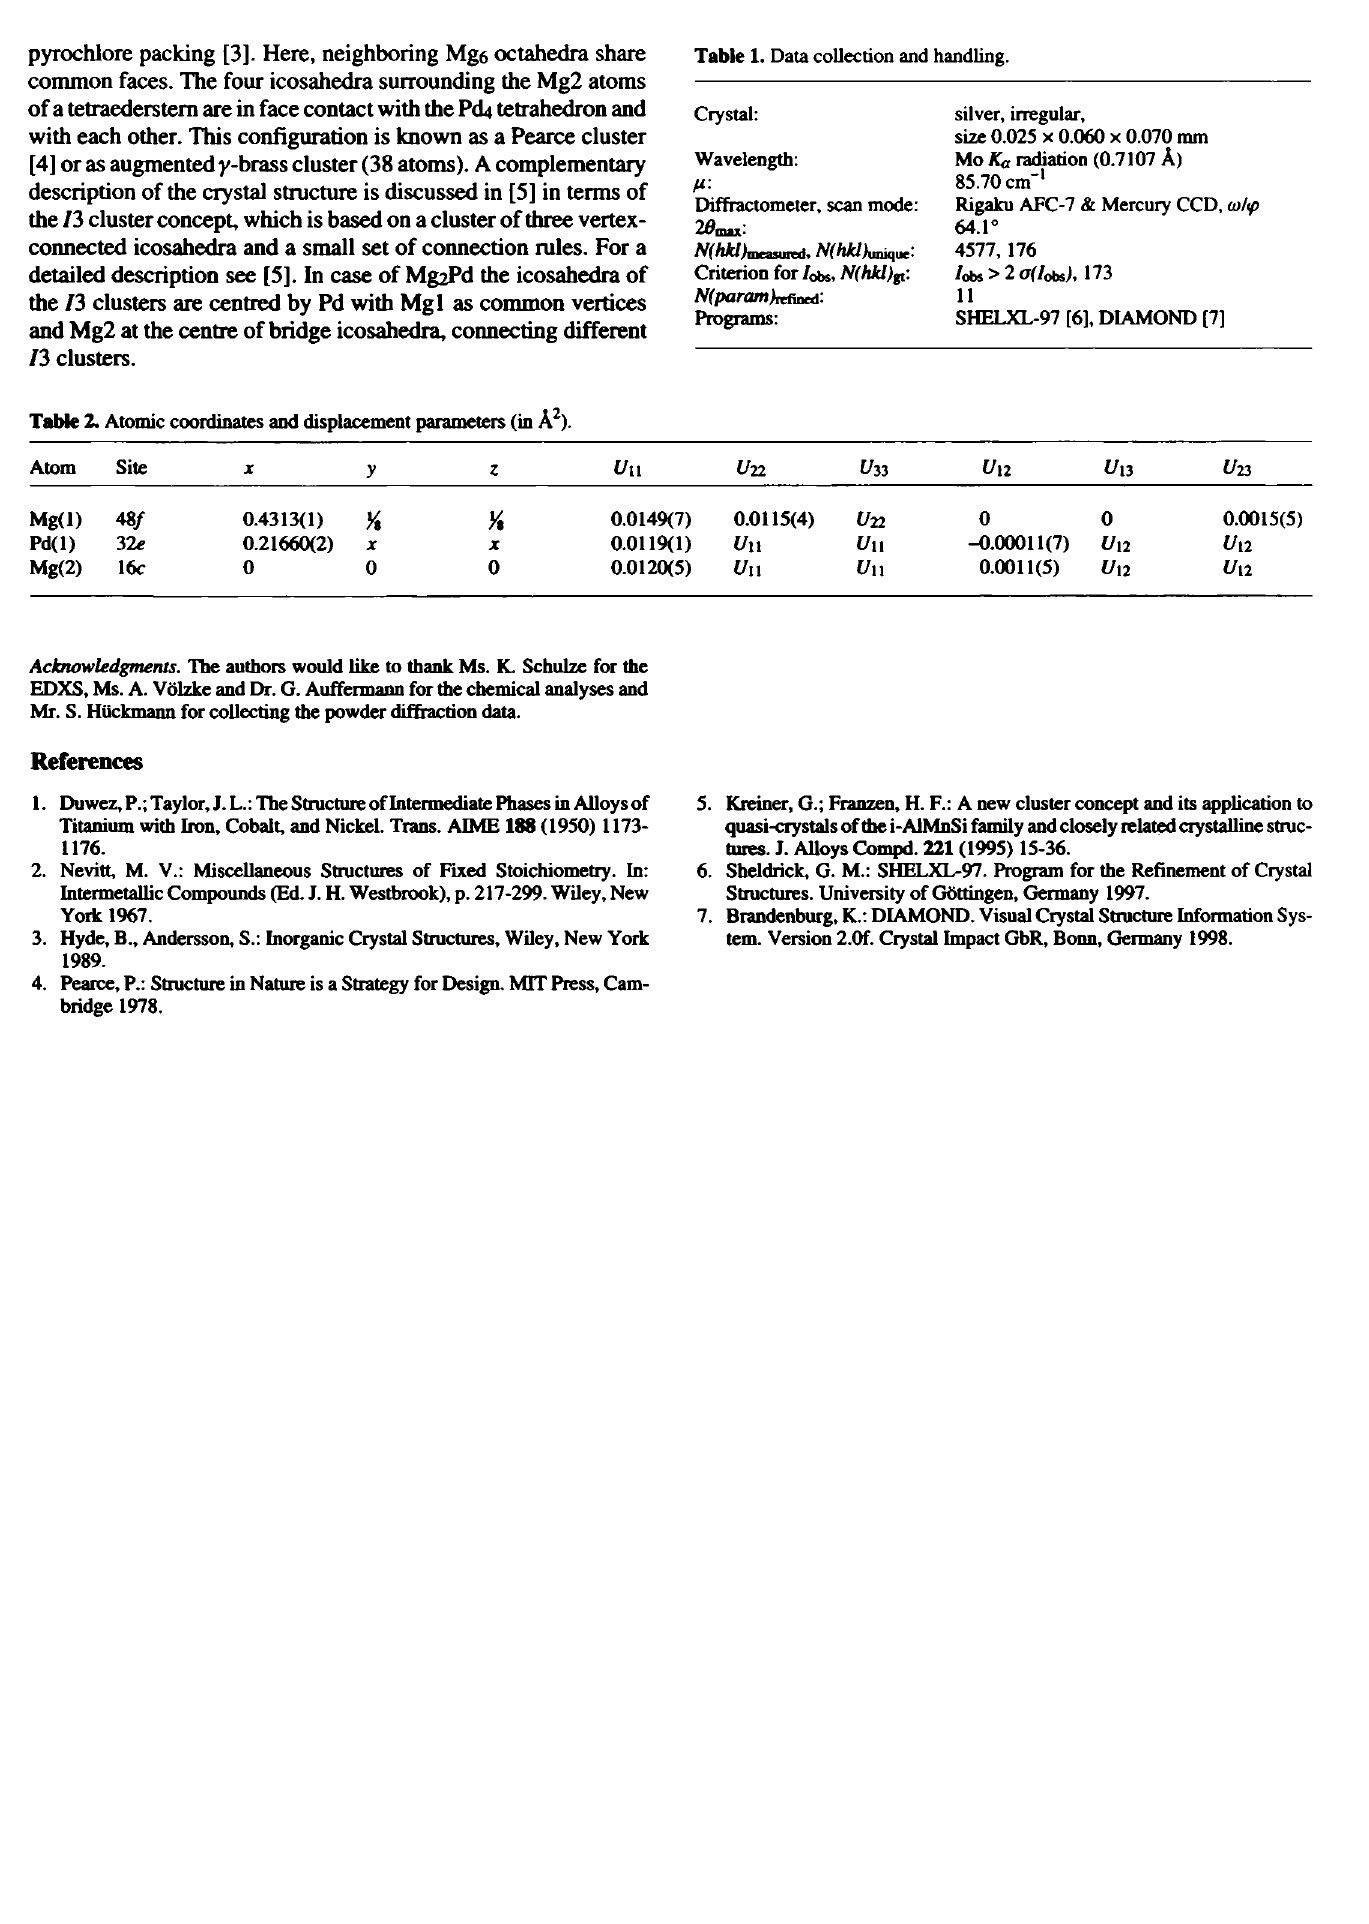
Table 2. Atomic coordinates and displacement parameters (in A 2 ).